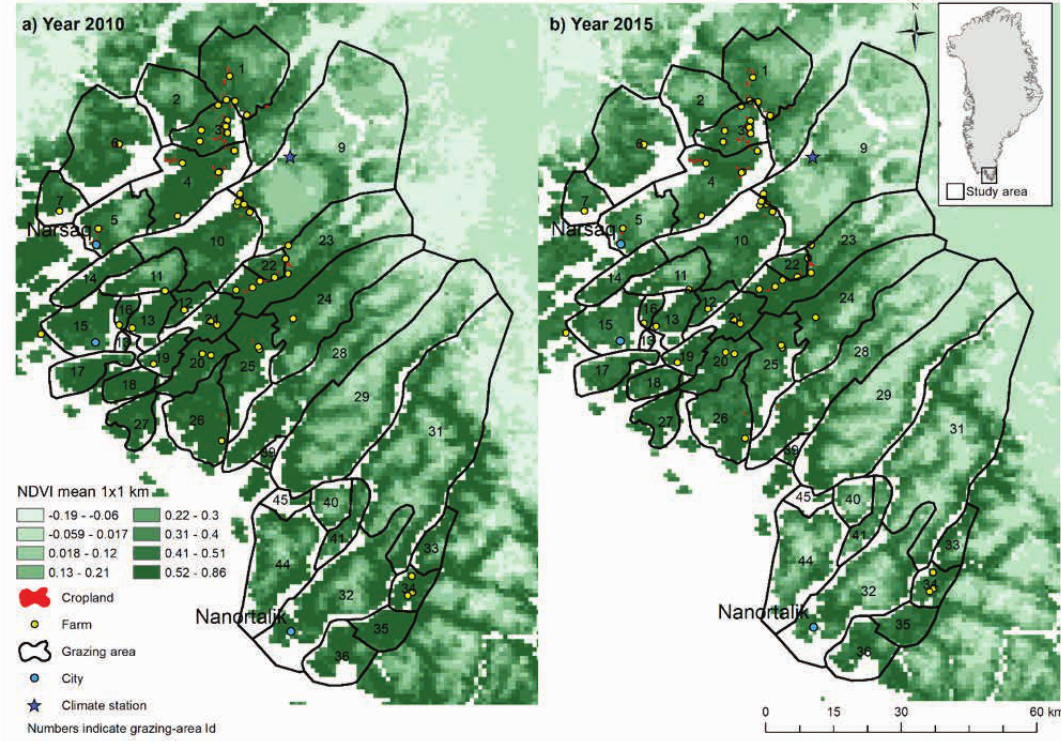
Figure 1: Location of farms and grazing areas in southern Greenland overlaid with average annual mean NDVI for 2010 (left) and 2015 (right) in 1 x 1 km